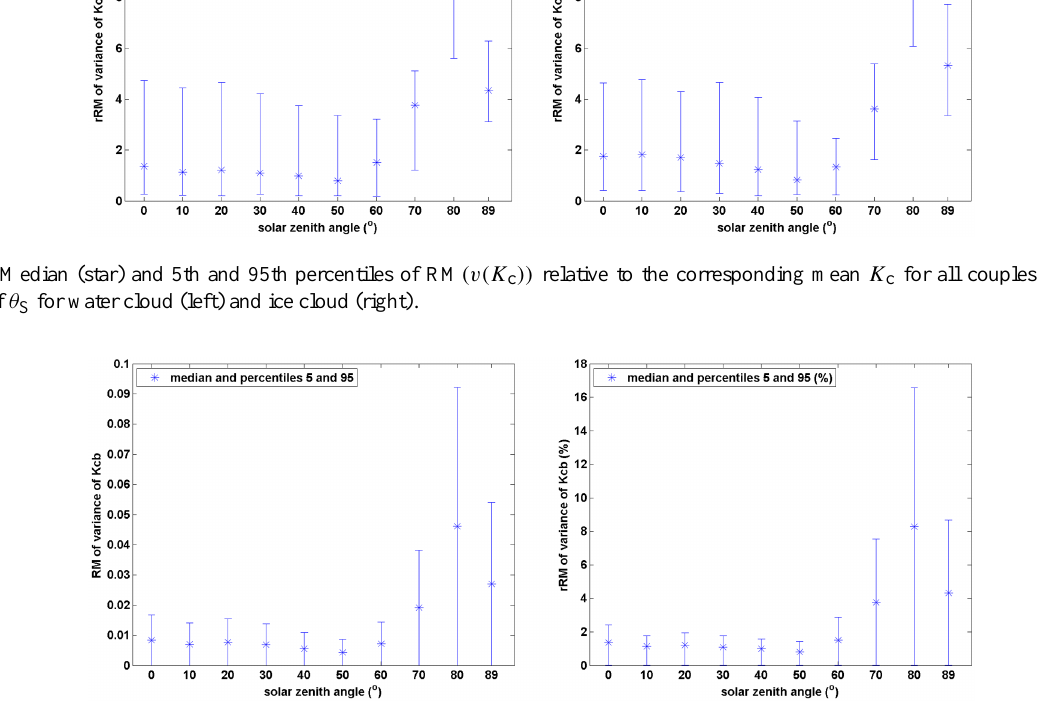
Figure 5. Median (star) and 5th and 95th percentiles of RM( v(K cb )) for all couples ( ρ g , τ c ) as a function of θ S . Absolute values (left), relative to the corresponding mean K cb